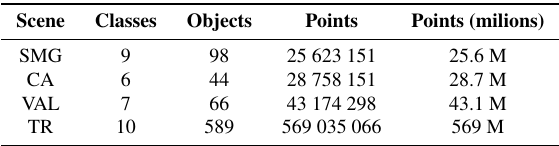
Table 1. Points cloud acquired by the “Politecnico di Torino”